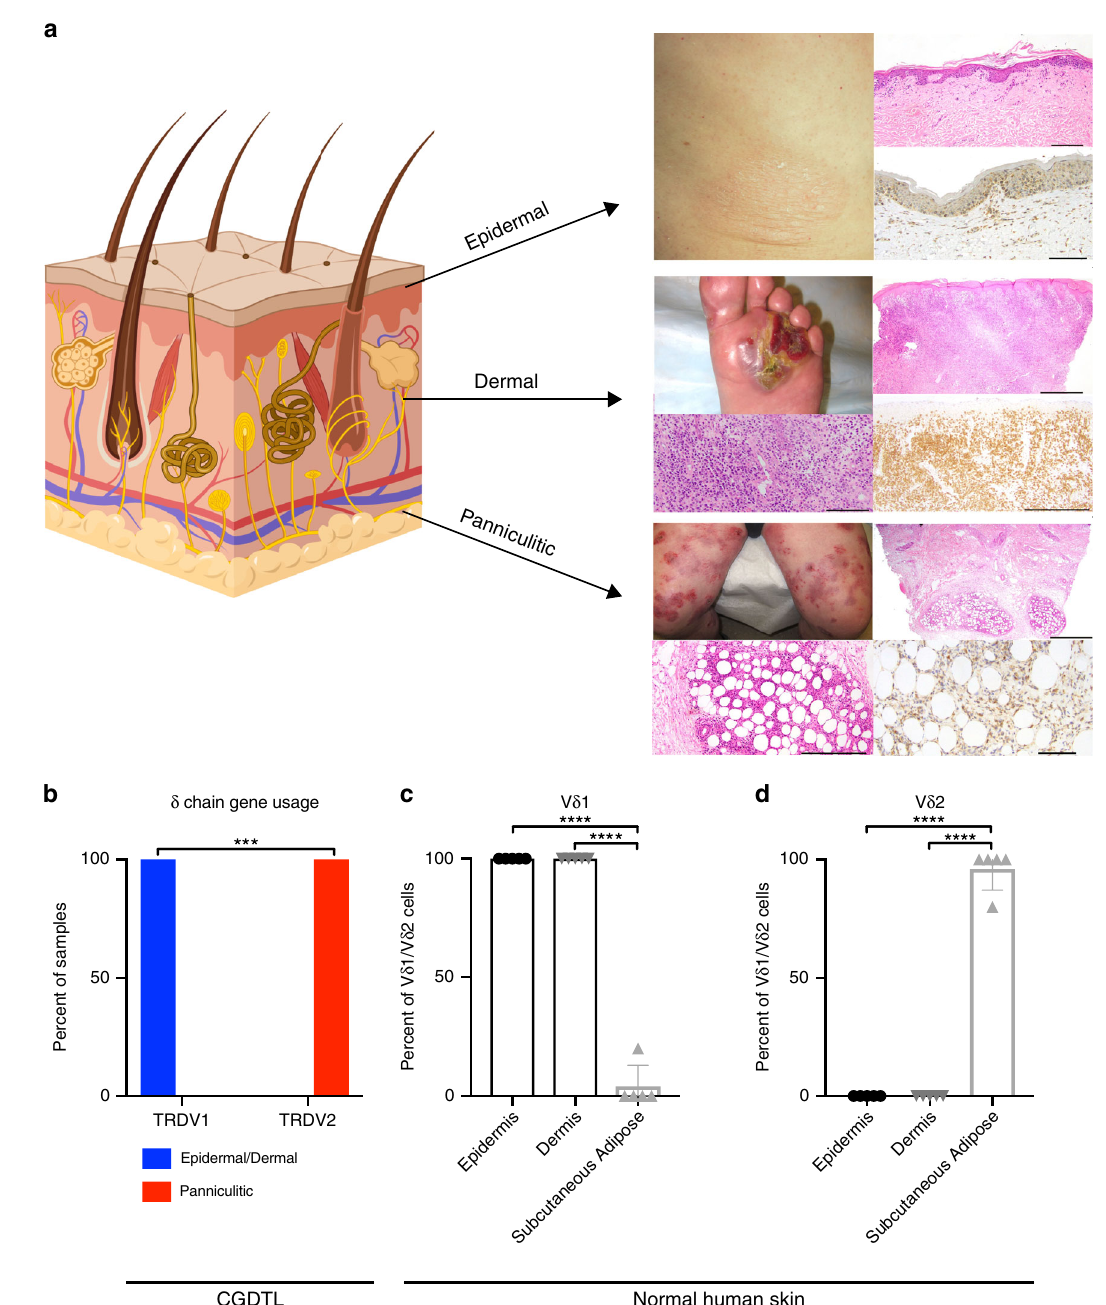
Fig. 1 Epidermal/dermal and panniculitic CGDTLs derived from distinct cells of origin. a Schematic highlighting distinct clinical and histological presentations of disease involving epidermis, dermis, or subcutaneous tissue. Clinical photographs of disease lesions, hematoxylin and eosin staining of biopsies, and γδ T cell receptor immunostaining (see “ Methods ” section) for representative patients with epidermal, dermal, and panniculitic disease are shown. Skin schematic created with BioRender. Scale bar represents 100 μ m in bottom right epidermal panel, bottom left dermal panel, and bottom right panniculitic panel; 200 μ m in top right epidermal panel, bottom right dermal panel, and bottom left panniculitic panel; 500 μ m in top right dermal panel and top right panniculitic panel. b Frequency of δ chain usage by skin compartment in CGDTL as assessed by RNA-seq and high-throughput TCR-Seq. Lymphomas involving epidermis and/or dermis ( n = 8) or subcutaneous tissue (panniculitic) ( n = 7). *** Indicates P value = 0.0002, two-sided Fisher ’ s exact test. c , d Flow cytometry analysis showing percentage of V δ 1 and V δ 2 T cells in normal human epidermis, dermis, and subcutaneous tissue ( n = 5). Dots represent individual values, horizontal line represents mean, and error bars represent standard deviation. **** Indicates P value < 0.0001, one-way ANOVA followed by Tukey ’ s multiple comparison test. Source data are provided as a source data fi